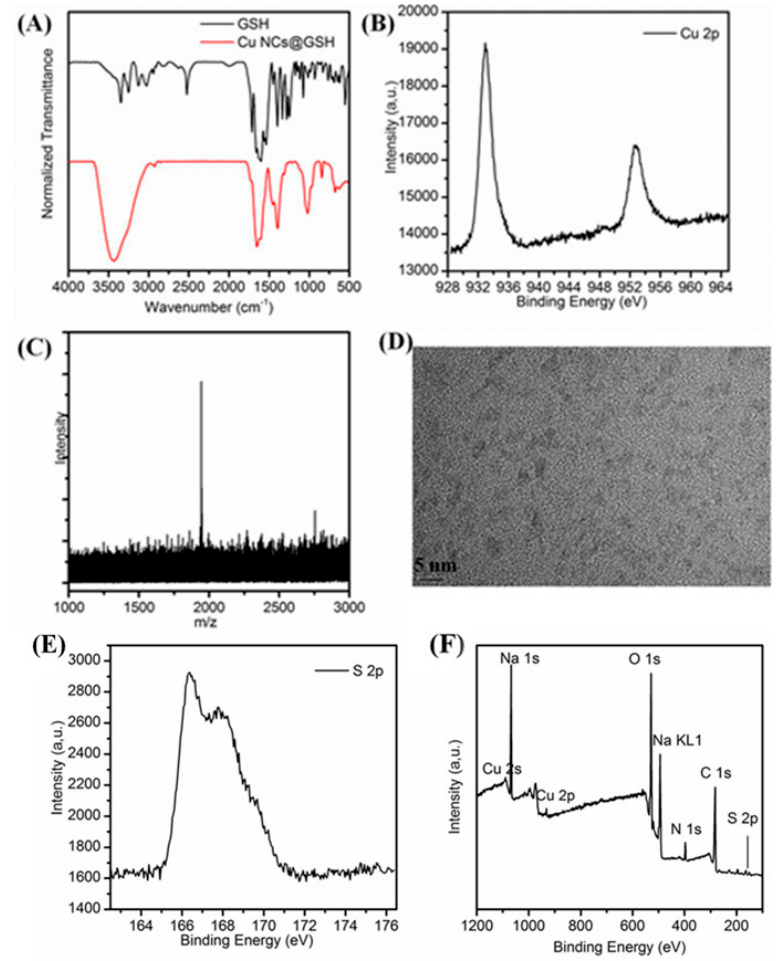
Figure 5. ( A ) Infrared spectra of the as-prepared Cu NCs@GSH and GSH; ( B ) Cu 2p XPS spectrum; ( C ) ESI-MS spectra; ( D ) HRTEM image of the as-prepared Cu NCs; ( E ) S 2p XPS spectrum; ( F ) whole XPS spectrum of the as-prepared Cu NCs and C(1s), N(1s), O(1s), S(2p), Na(1s) and Cu (2p) core-level photoemission spectra all appeared on the XPS spectrum.